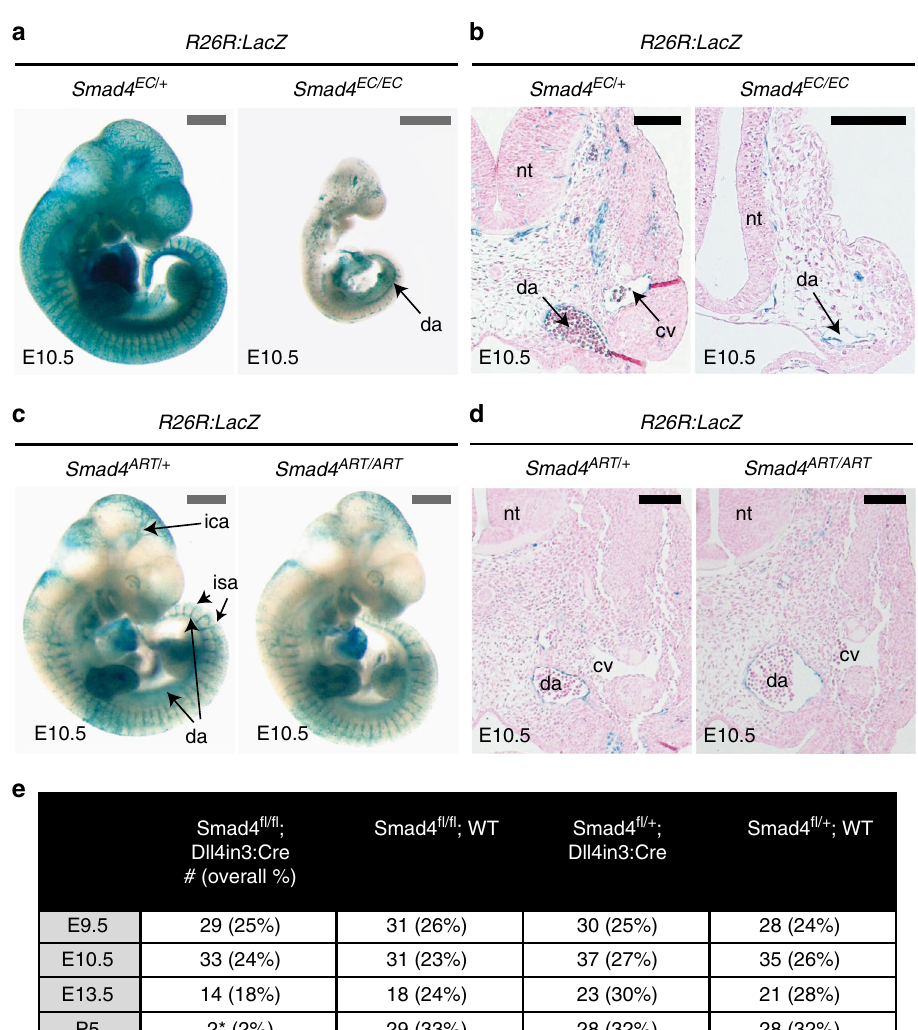
Fig. 3 Deletion of Smad4 speci fi cally in arterial endothelial cells does not affect vascular patterning or early embryonic development. a , b Representative pan-endothelial Tie2:Cre;Smad4 fl / + and Tie2:Cre;Smad4 fl / fl whole-mount images ( a ) and transverse sections ( b ) from E10.5 embryos also transgenic for the Cre-reporter Rosa26R:LacZ . The cardinal vein (cv) cannot be identi fi ed in the Smad4 fl / fl embryo, although the dorsal aorta (da) can be seen in both. Grey scale bars are 500 μ m, black scale bars are 100 μ m. c , d Representative arterial-speci fi c Dll4in3:Cre;Smad4 fl / + and Dll4in3:Cre;Smad4 fl / fl whole-mount images ( c ) and transverse sections ( d ) from E10.5 embryos also transgenic for the Cre-reporter Rosa26R:LacZ . Arterial-speci fi c deletion of Smad4 had no effect on vasculature development at E10.5. Grey scale bars are 500 μ m, black scale bars are 100 μ m. e Observed frequency of Smad4 fl / fl ;Dll4in3:Cre embryos from E9.5 to P5. Only two sick (*) P5 Smad4 fl / fl ;Dll4in3:Cre animals were recovered. EC indicates Tie2:Cre-mediated deletion, ART indicates Dll4in3:Cre-mediated deletion, da = dorsal aorta, nt = neural tube, cv = cardinal vein, ica = inner cerebral artery, isa = intersomitic arteries. See